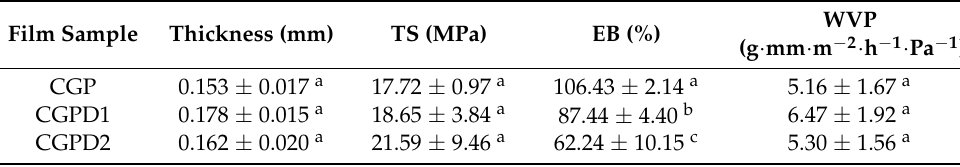
Table 1. Mechanical properties and water vapor permeability of